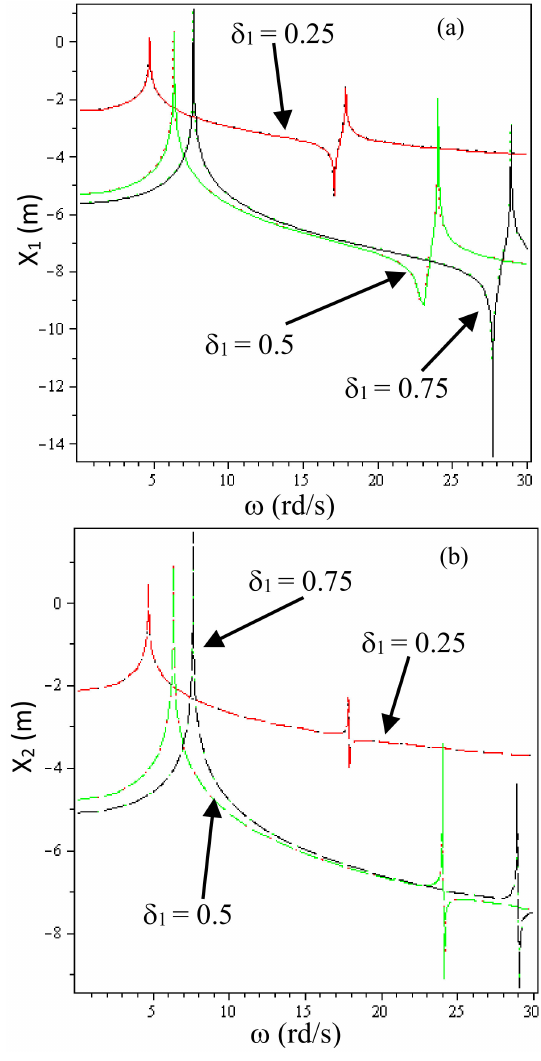
Figure 16. ( a ). Displacement x 1 versus the circular natural frequency ω . Superposition of the solution by the RPM approach (____) and the exact solution (—–). ( b ). Displacement x 2 versus the circular natural frequency ω . Superposition of the solution by the RPM approach (____) and the exact solution (—–).